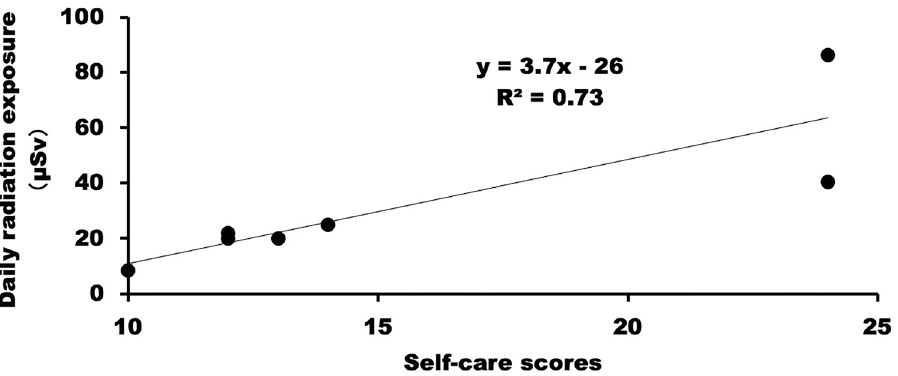
Figure 3. Relationship between self-care score and daily radiation exposure. The self-care scores were positively correlated with daily radiation exposure among